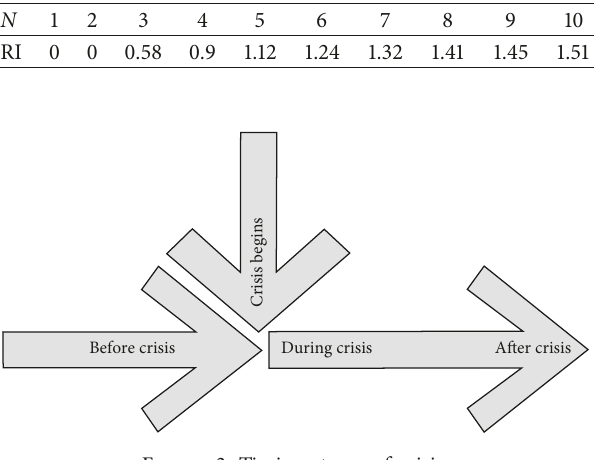
Figure 3: Timing stages of